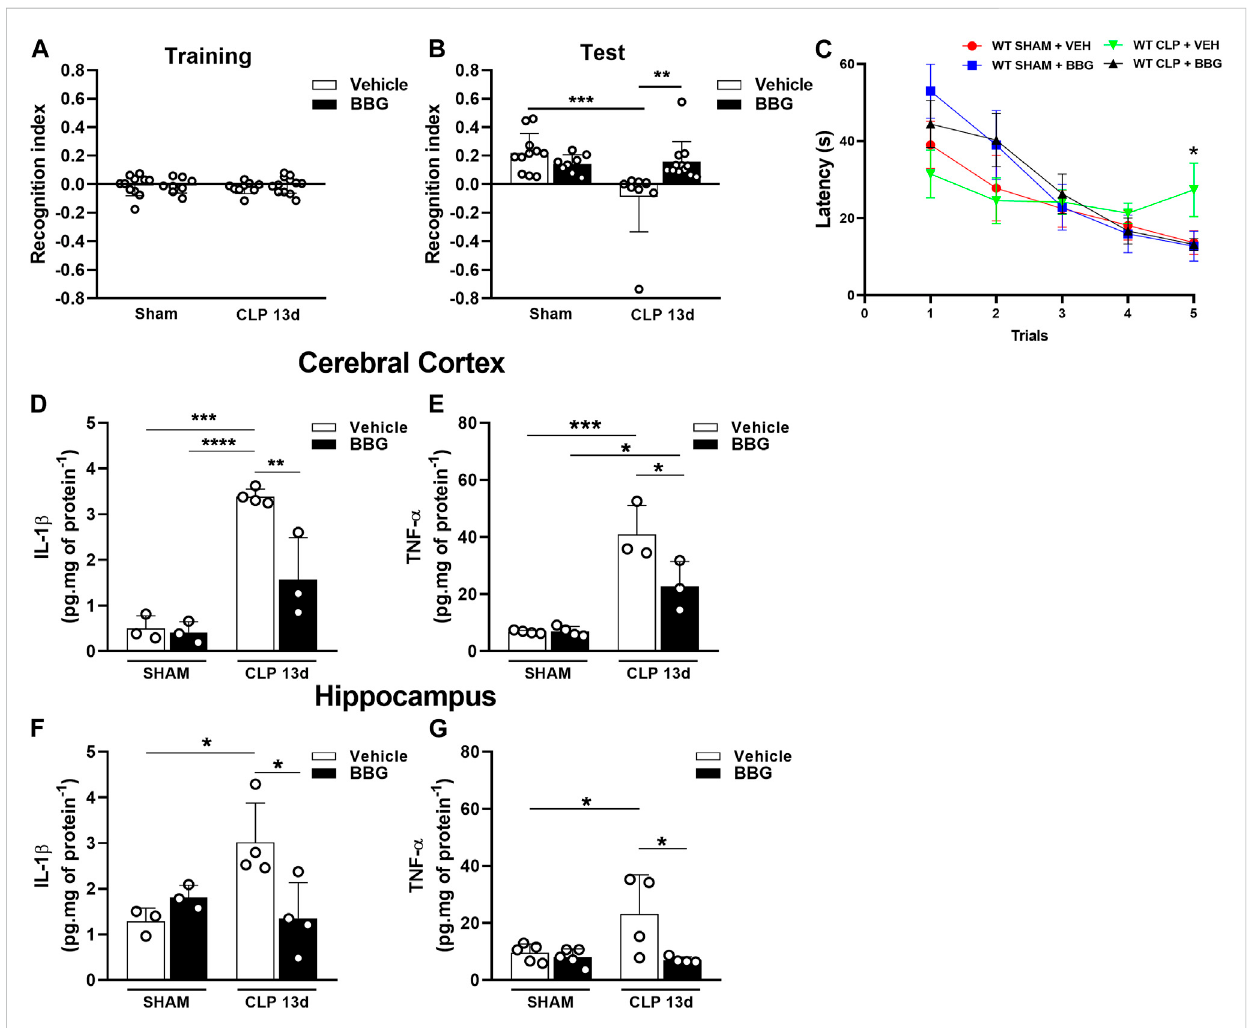
FIGURE 5 P2X7 receptor blockade with the selective antagonist BBG restored short-term memory impairment and reduced cytokine production in sepsis- surviving mice 13 days after surgery. Recognition index in the Novel object recognition test (NORT) for CLP and sham animals treated with BBG (45 mg/kg)orvehicle(PBS+DMSO0.2%)13 dayspost-surgeryduringthetrainingwithfamiliarobjects (A) ,andthetestwithfamiliarandnovelobjects (B) . CLPandshamanimalstreatedwithBBG(45 mg/kg)orvehicle(PBS+DMSO0.2%)subjectedtoWaterT-mazetest(WTMT) (C) .Cytokineproduction IL-1 β (D) andTNF- α (E) inthecerebralcortex,andhippocampus (F,G) ( n =3 – 6).Dataareexpressedasmean±SEM;One-wayANOVAfollowedbyTukey ’ s post hoc for recognition index and cytokine production and Two-way ANOVA followed by Tukey ’ s for WTMT. Statistical differences between groups are represented by asterisks (* p < 0.05; ** p < 0.005; *** p < 0.0005). ( n = 8 – 12). The recognition index was calculated by subtracting the time exploring the familiar object from the time exploring the novel object, divided by the total exploration